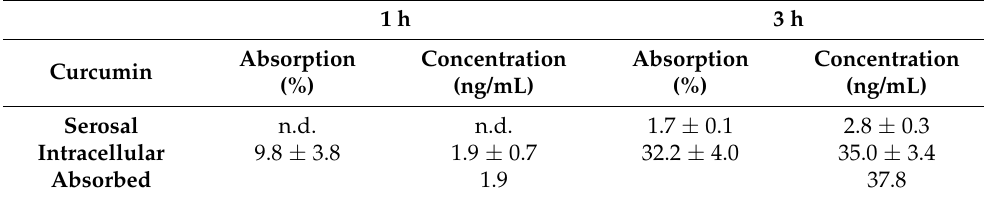
Table 3. Curcumin bioavailability and cellular accumulation following intestinal epithelium exposure to LENILUTS ® for 1 and 3 h. Results are expressed as percentage of absorption and concentration (mean ± standard deviation). N.d.: not determined.